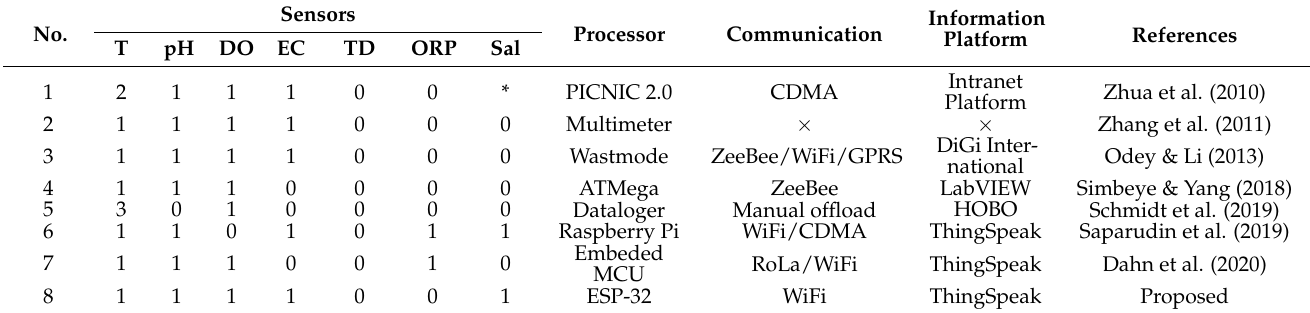
Table 1. Comparisons of water quality monitoring systems for